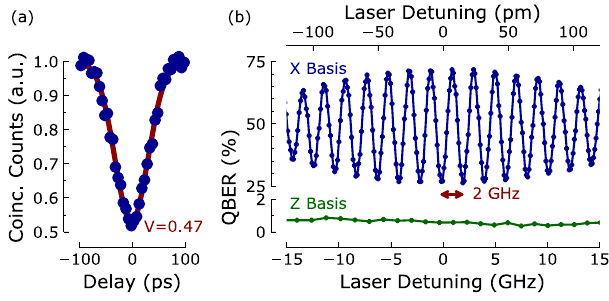
Fig. 2 Interference between pulses from Alice & Bob. a Hong – Ou – Mandel interference as a function of temporal delay. b Measured QBER as a function of spectral detuning between Alice & Bob ’ s